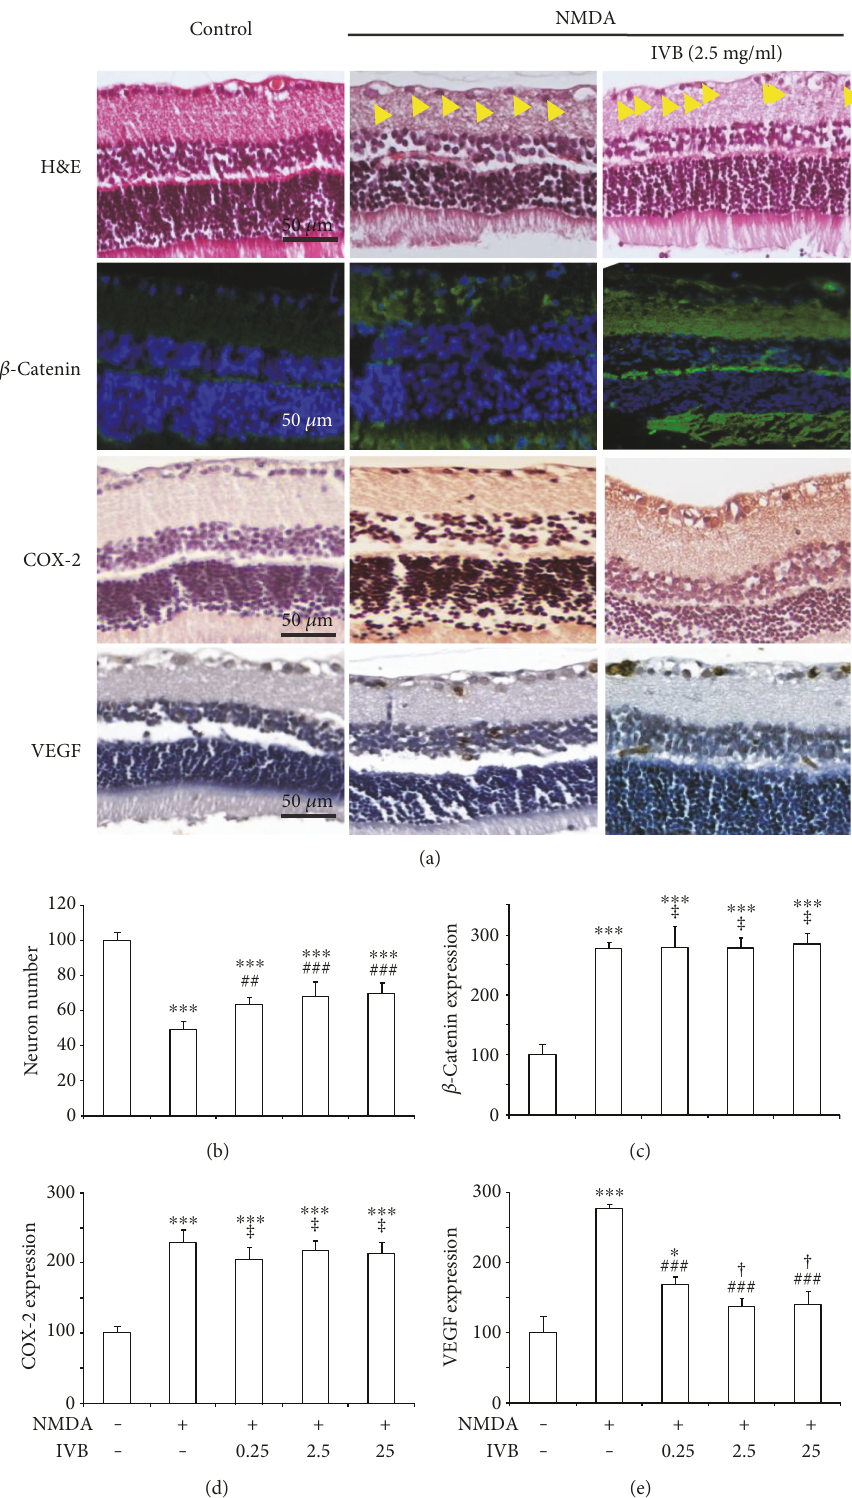
Figure 5: IVB could ameliorate retinopathy caused by NMDA through reducing VEGF expression (a) Representative images (H&E staining, expression of β -catenin, COX-2, and VEGF) of the rats. (b) Neuron number of RGCs with respect to control (untreated), in NMDA-injected retinas of animals treated with IVB. (c) β -Catenin expression of retinas with respect to control in NMDA-injected retinas of animals treated with IVB. (d) COX-2 expression of retinas with respect to control in NMDA-injected retinas of animals treated with IVB. (e) VEGF expression of retinas with respect to control in NMDA-injected retinas of animals treated with